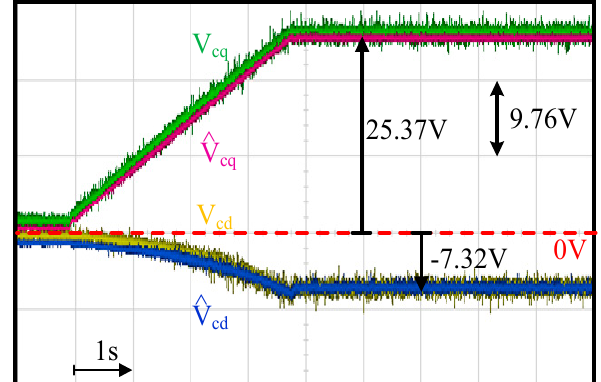
Figure 11. Experiment of capacitor voltage estimation performance (acceleration from 6 krpm to 42 krpm within 4 s and fan